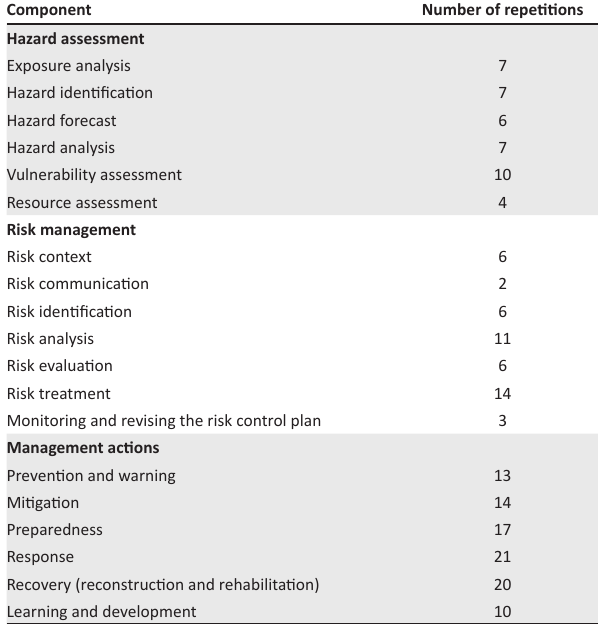
TABLE 2: Identified themes in hazard assessment, risk management and management